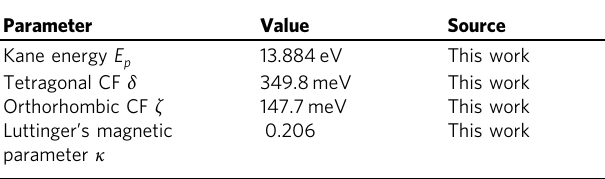
Using the expressions in Supplementary Table 1 of Supplementary Note 1, the Kane energy, E p , the crystal fi eld parameters δ and ζ and Luttinger ’ s magnetic parameter κ are uniquely determined by measurement of the electron and hole g-factors along two directions. The measured values are taken as g h Z ¼ (cid:3)j g h ½ 001 (cid:2) j = − 0.28; g h ½ 1 (cid:1) 10 (cid:2) ¼ (cid:3) 0 : 57 for the holes, g e Z ¼ g e ½ 001 (cid:2) ¼ 2 : 52 and g e ½ 1 (cid:1) 10 (cid:2) ¼ 2 : 63. For these calculations, the bandgap, E g , is taken as 1.65eV corresponding to the measured exciton energy and the SOC parameter Δ ¼ 1 : 4 eV from ref. 24 . The calculated g-factor values match the experimental ≈ 130 ns, ref. 36 ) and CdTe quantum wells ( τ (cid:4) ≈ 30 ns, ref. 50 ) ( τ (cid:4) 2 2 even though that the pulse-to-pulse time period, t rep was much in both cases. Given that t rep is smaller than the extracted τ (cid:4) 2 actively stabilized to 1.5 ps, and the magnetic fi eld is measured to 0.1 Gauss, the RSA method is able to determine the spin lifetime as long as 5 μ s, even that t rep is ~2 orders of magnitude shorter (see ref. 36 . and ref. 40 ).